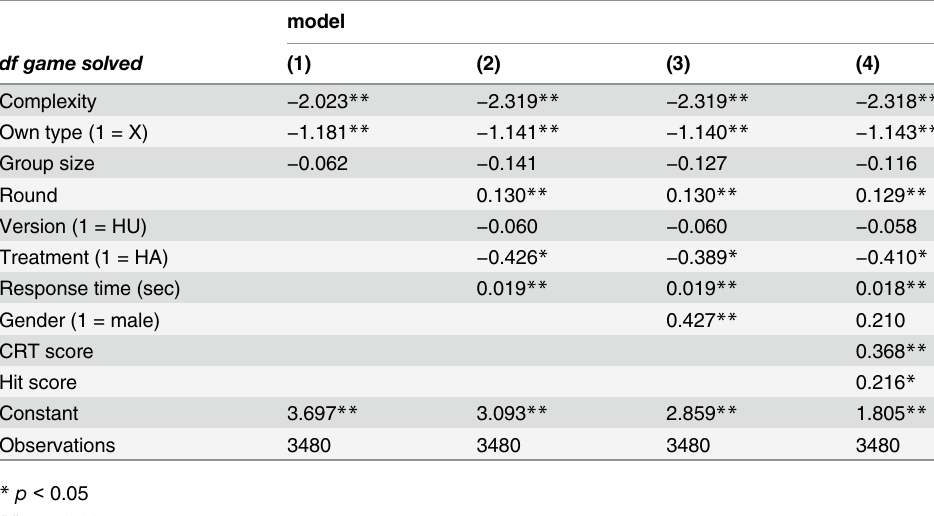
Table 10. Random effects logistic regressions on solving a df